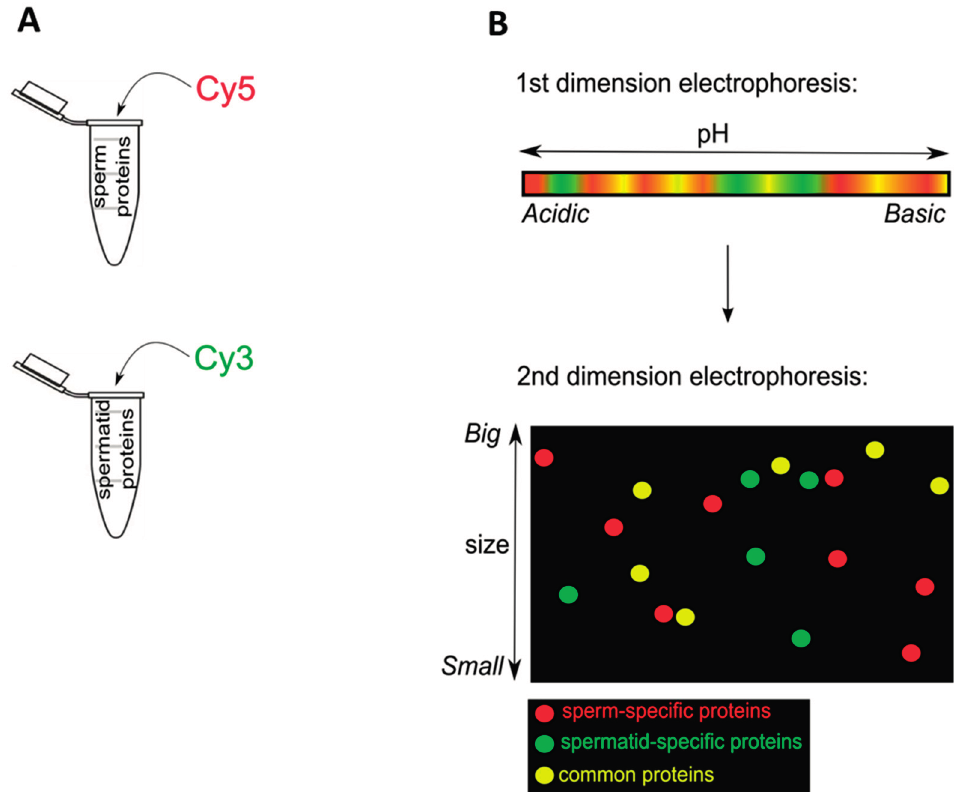
Figure 1. Experimental design for 2-D Fluorescence Difference Gel Electrophoresis (2D-DIGE) analysis. ( A ) The same quantity of proteins isolated from sperm or spermatids was labelled with Cy5 (red) or Cy3 (green) dye; ( B ) After labelling, proteins were mixed and separated in the first dimension electrophoresis in the pH range, according to isoelectric points of proteins. Subsequently, the proteins were run in the second dimension electrophoresis, according to the molecular weight of proteins. These two runs allowed separation of proteins into spots of three colours: in this example the red spots were sperm-specific; the green ones spermatid-specific and the yellow ones were proteins present in both cell